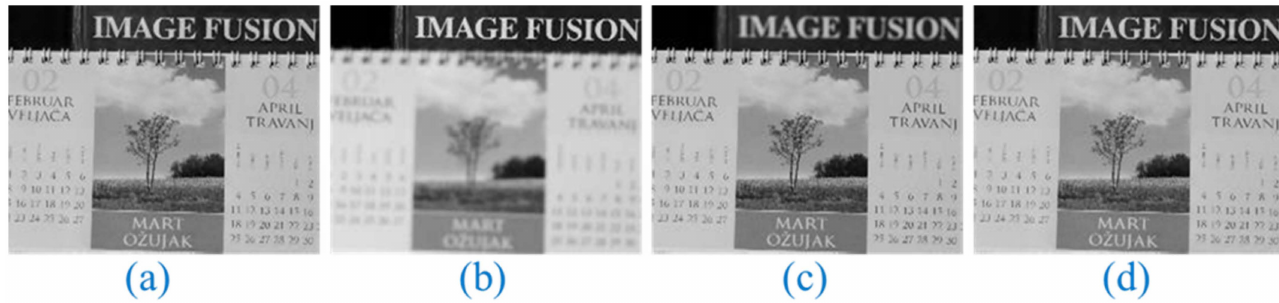
Figure 8. Multi-focus image of a calendar from various perspectives. Original Image: ( a ), Multi-focus Input Images: ( b , c ), and Proposed Fusion: ( d ). Table 1. The performance of the proposed methodology for a couple of trailing images.